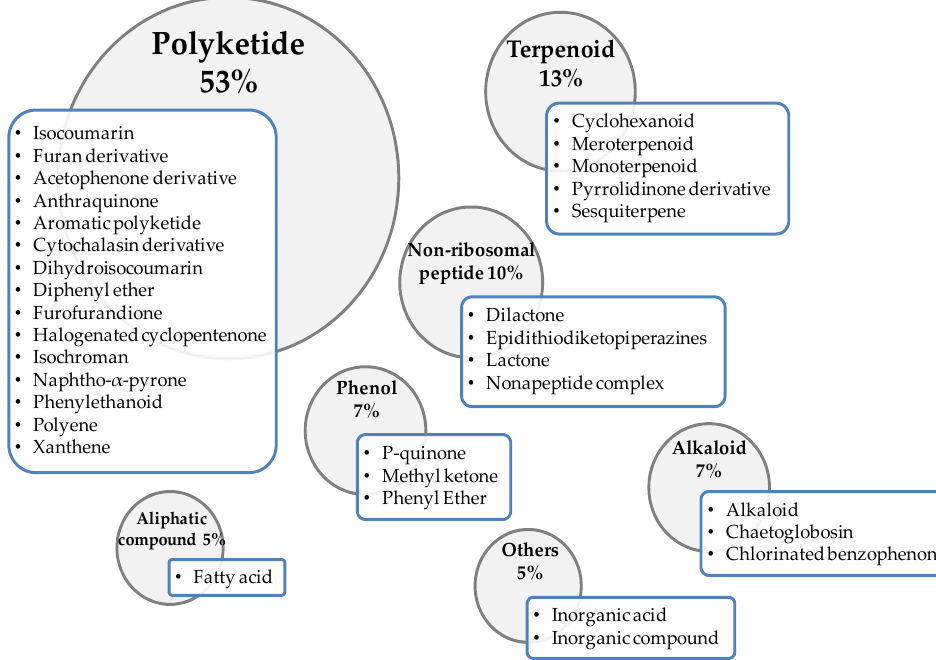
Figure 1. Graphical abstract of the different categories in which the fungal metabolites with antifungal properties are included, indicating the percentage of compounds in each category.